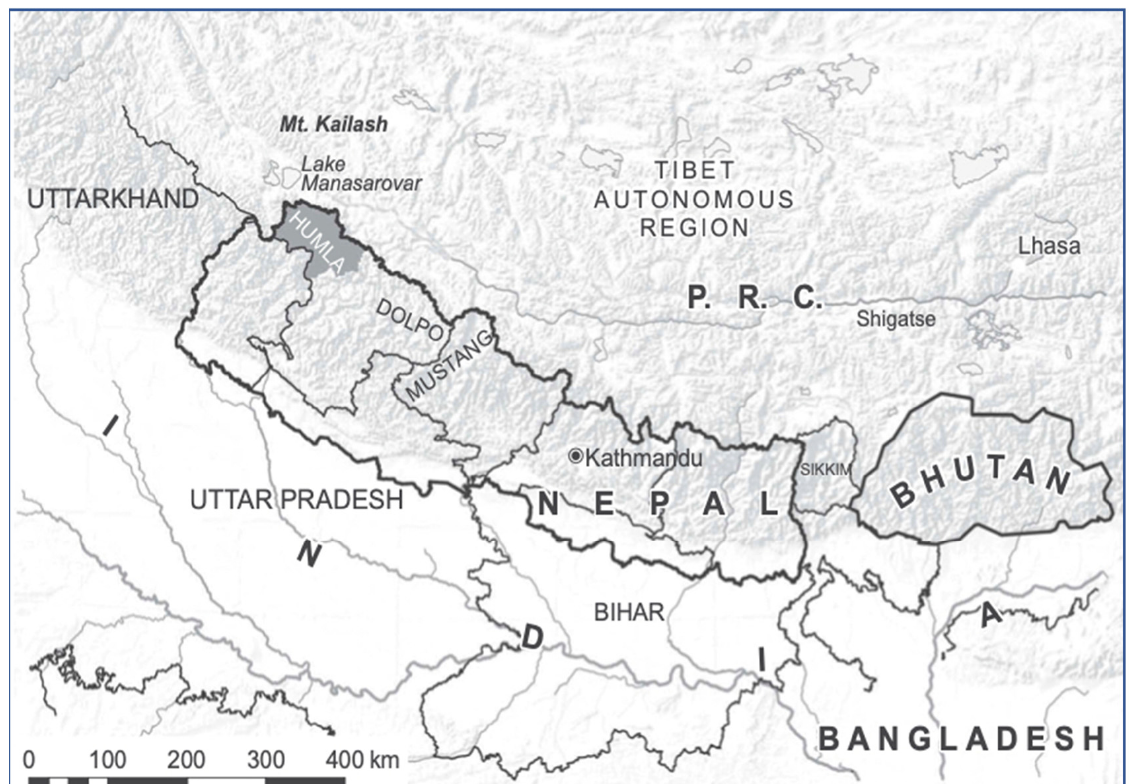
Figure 1. The regional context of Humla District. Digital cartography by Mark Henderson.